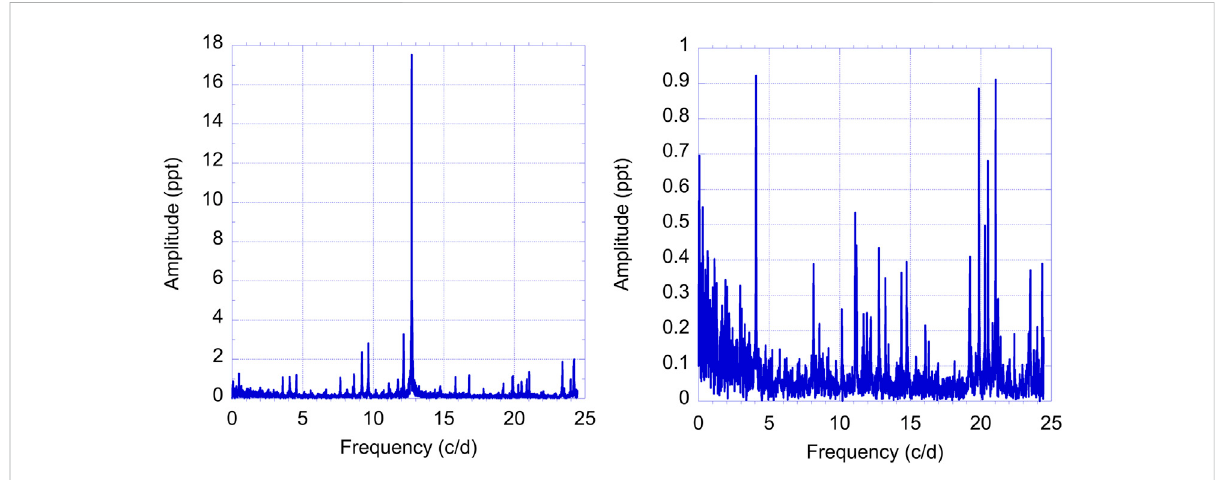
FIGURE 2 Left: FG Vir K2 amplitude spectrum from 0 to 24.5 c/d. Right: Amplitude spectrum after pre-whitening modes with amplitude > 1